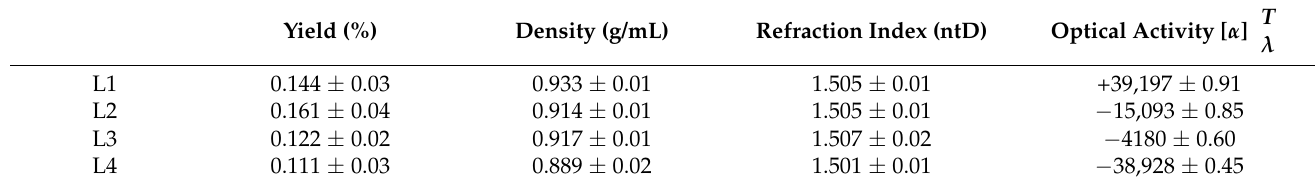
Table 4. Physical properties of Siparuna muricata